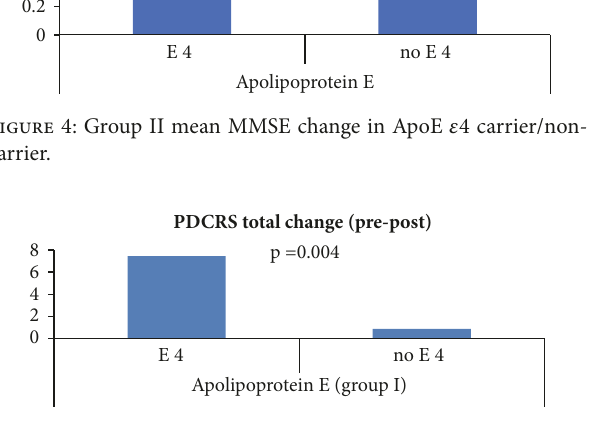
Figure 5: Group I mean PDCRS change in ApoE 𝜀 4 carrier/non- carrier group.